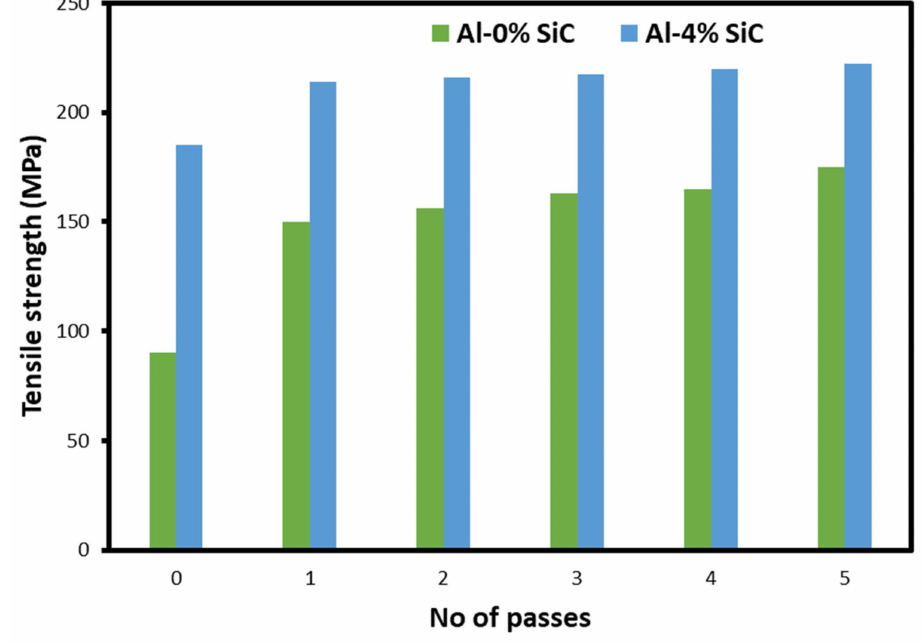
Figure 10. Tensile strength of Al–SiC nanocomposite sheets after five ARB